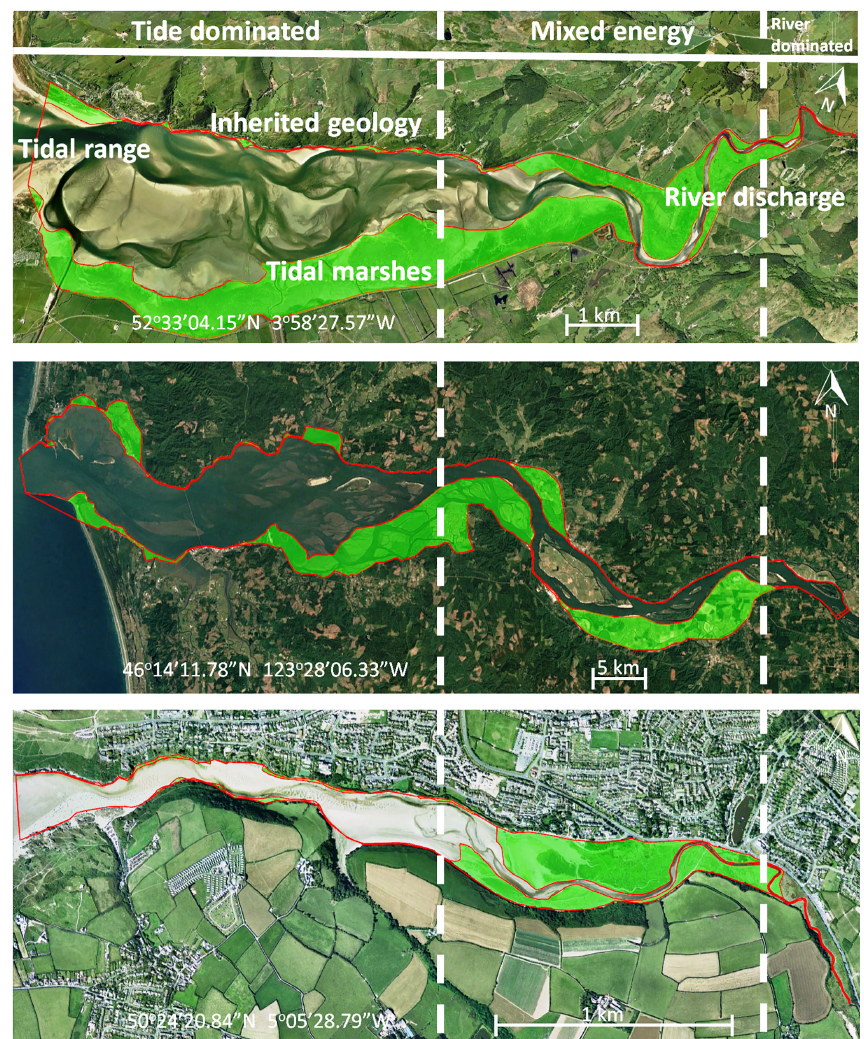
Figure 1. Active and vegetated parts of estuaries, showing proportionally more vegetated area in the upstream transition from single- thread river to multi-thread estuary. The estuaries are the Dyfi (UK), Columbia (USA) and Gannel (UK). The green areas are the vegetated parts of the estuary while the red lines project the morphologically active areas. Distinctions between dominant energy types are based on characteristic morphological features like tidal creeks, intertidal area, irregular shaped tidal bars and large meanders (Dalrymple et al.,